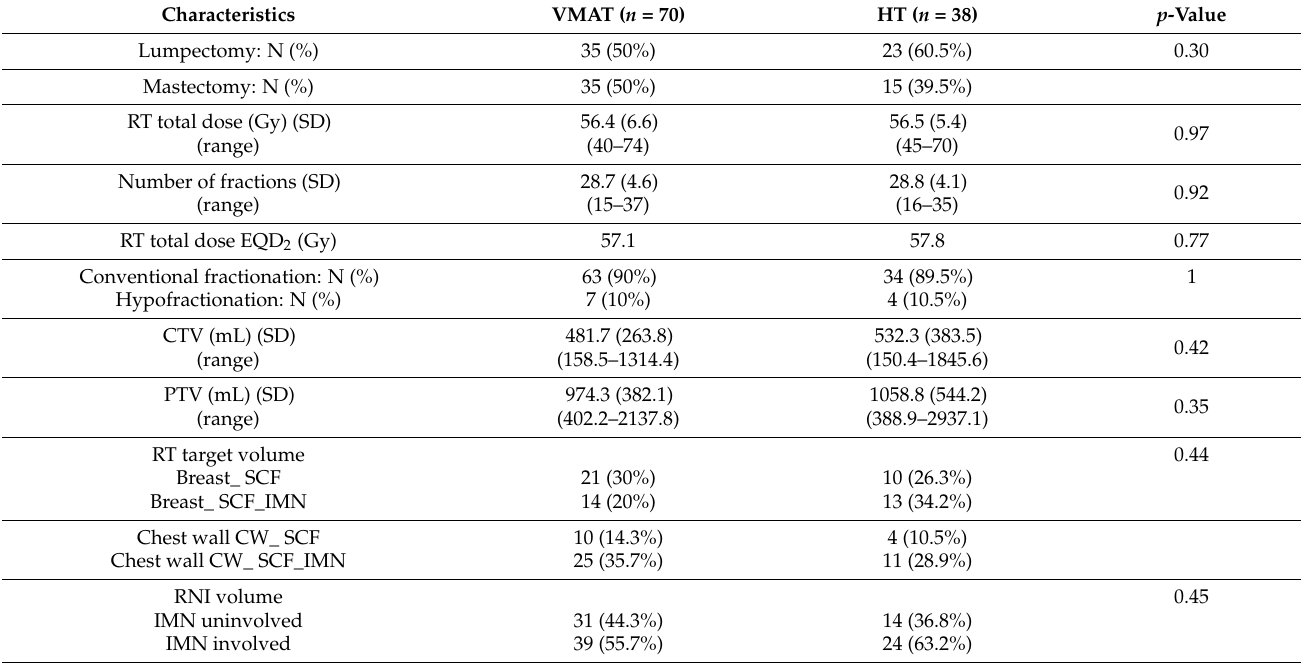
Table 1. Patient characteristics and RT treatment